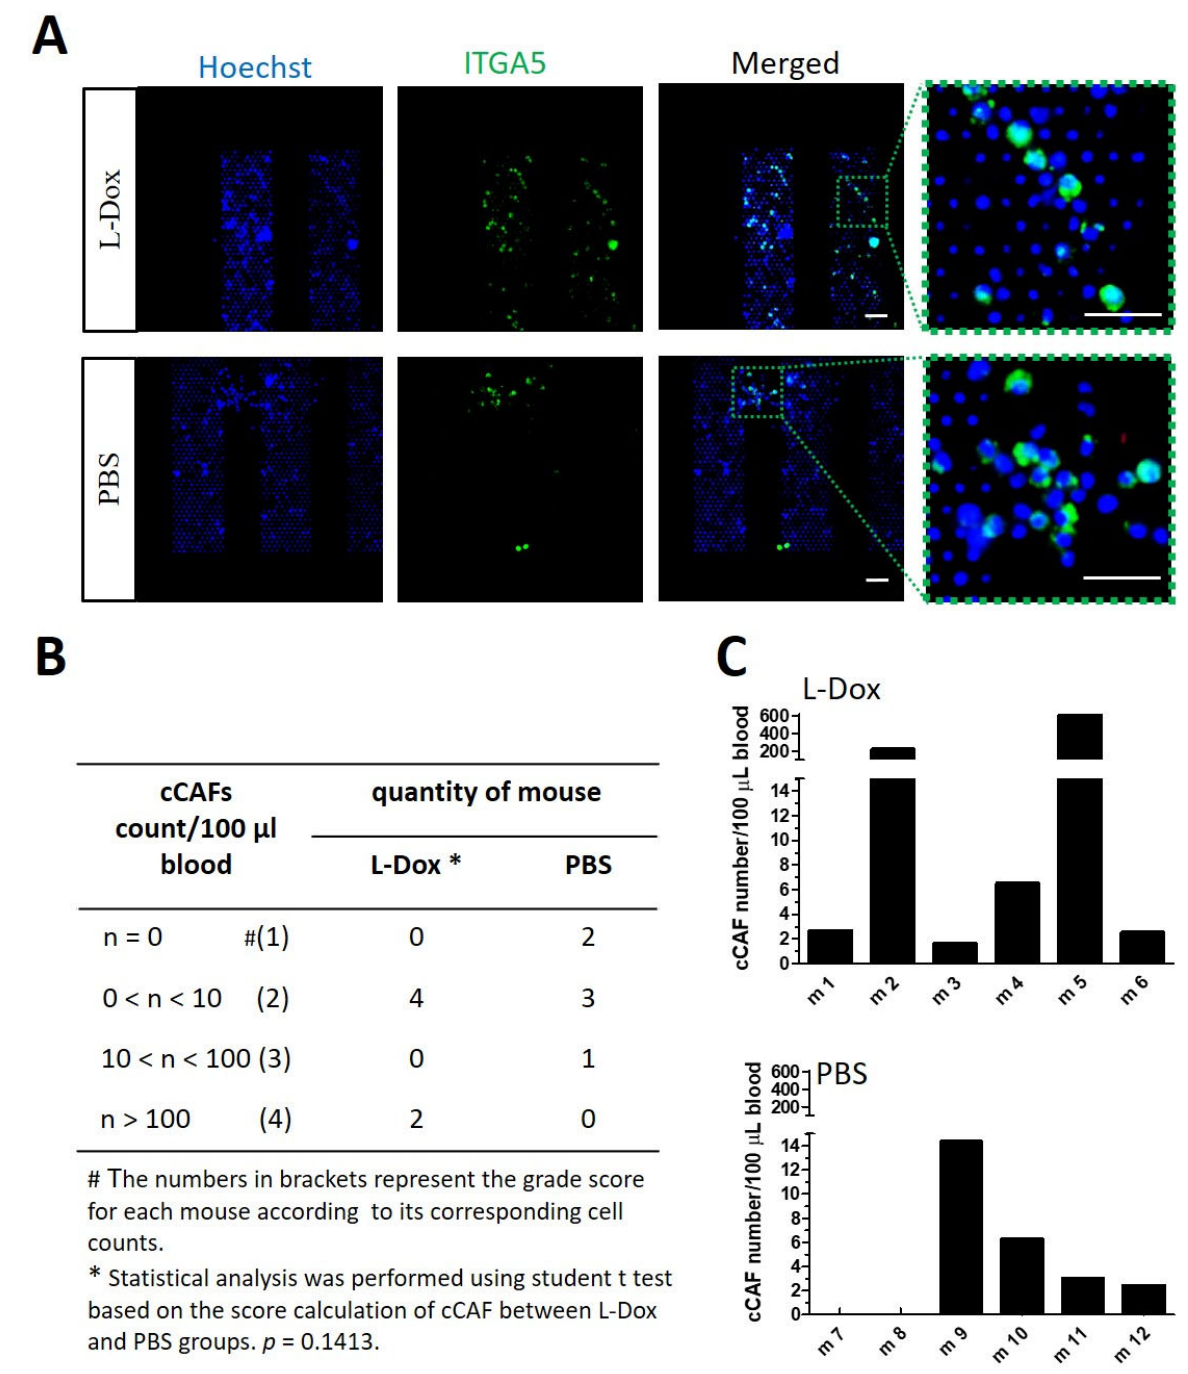
Figure 5. Chemotherapy treatment induced cCAFs in vivo. ( A ) Immunostaining of ITGA5 (green) in blood from mice treated with L-Dox (5 mg/kg once/week for 3 weeks) to detect cCAFs compared with untreated mice. Scale bar, 40 µ m. ( B ) Table listing the levels of cCAFs detected in mice treated with L-Dox or PBS. Statistics of ( C ) cCAF numeration for each mouse in the L-Dox- and PBS-treated groups. Statistical analysis was performed based on the grading score system according to the cCAF count of each mouse (score 1: 0 cCAFs; score 2: 0–10 cCAFs; score 3: 10–100 cCAFs; score 4: >100 cCAF)s using a two-sided unpaired Student’s t test, showing differences with p -values